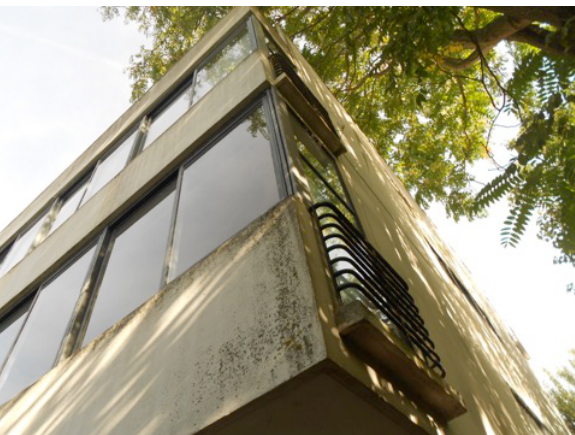
Figure 5. Detail of the South-East corner, current state [Di Resta, 2015]